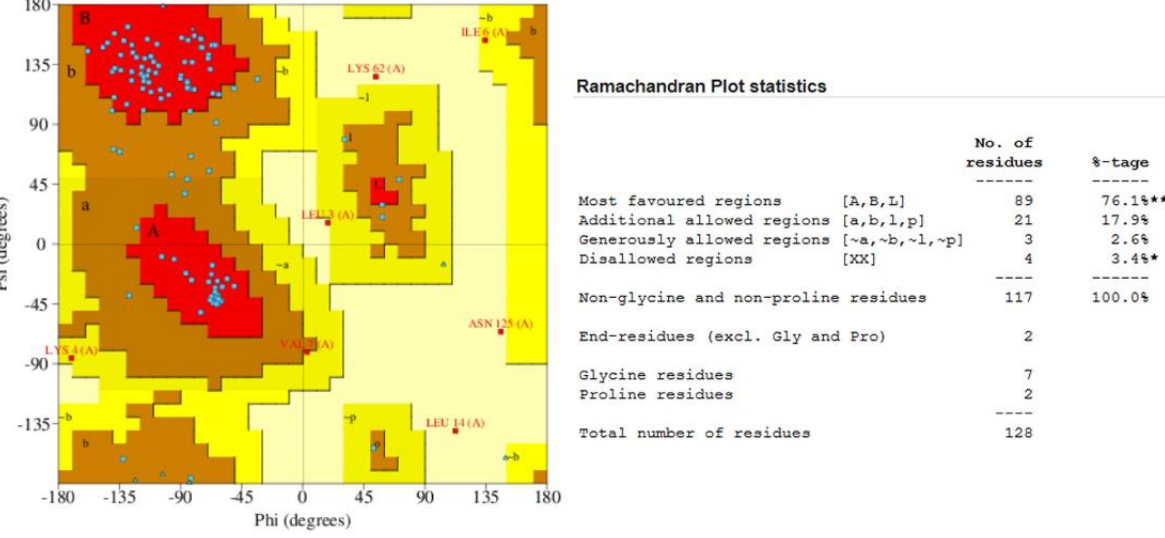
Figure 6. Validation of the ReFOLD-predicted protein structure using the Ramachandran plot. * p < 0.05, ** p < 0.01